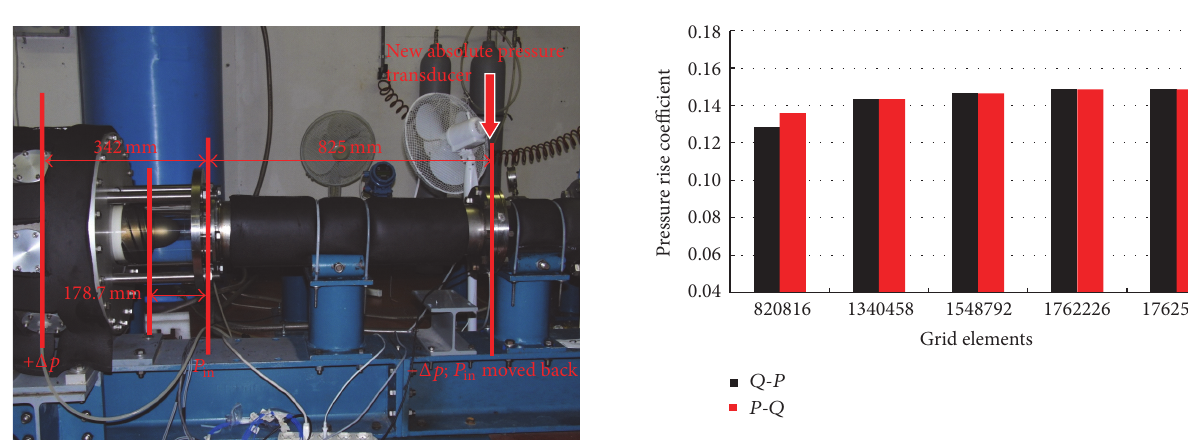
Figure 5: Grid independence check (mesh case 1 to